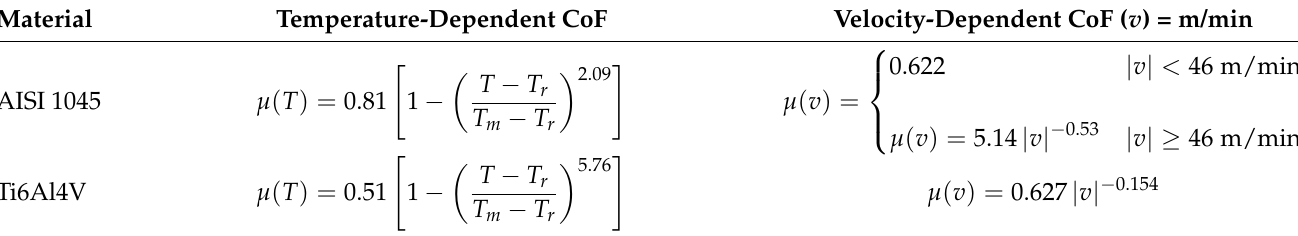
Table 5. Proposed coefficients of friction (CoF) for AISI 1045 and Ti6Al4V.